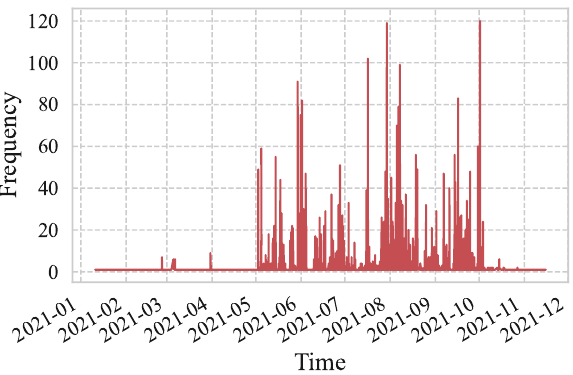
Figure 3. Lightning frequency statistics for the whole year of 2021.